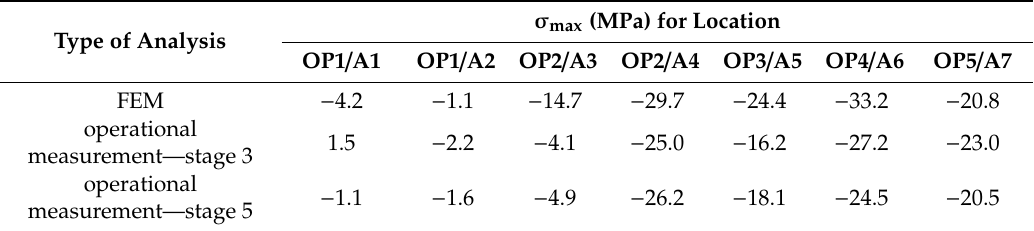
Table 8. Comparison of normal stress values in the direction of active gauges.